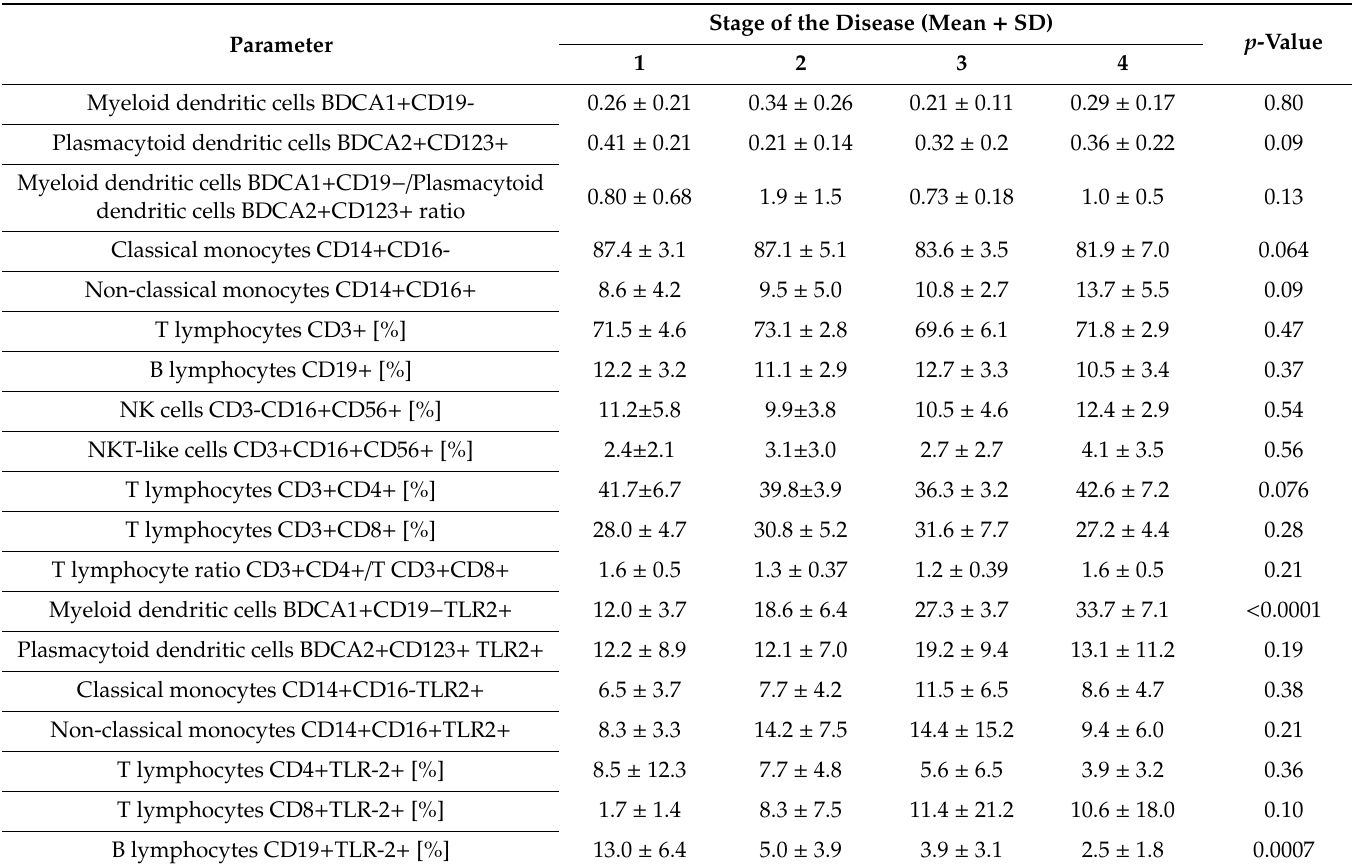
Table 3. The frequencies of the dendritic cell, monocyte, and basic peripheral blood lymphocyte subsets as well as the frequencies of these cell subsets expressing TLR2 antigen, for patients with endometriosis stage 1, 2, 3, and